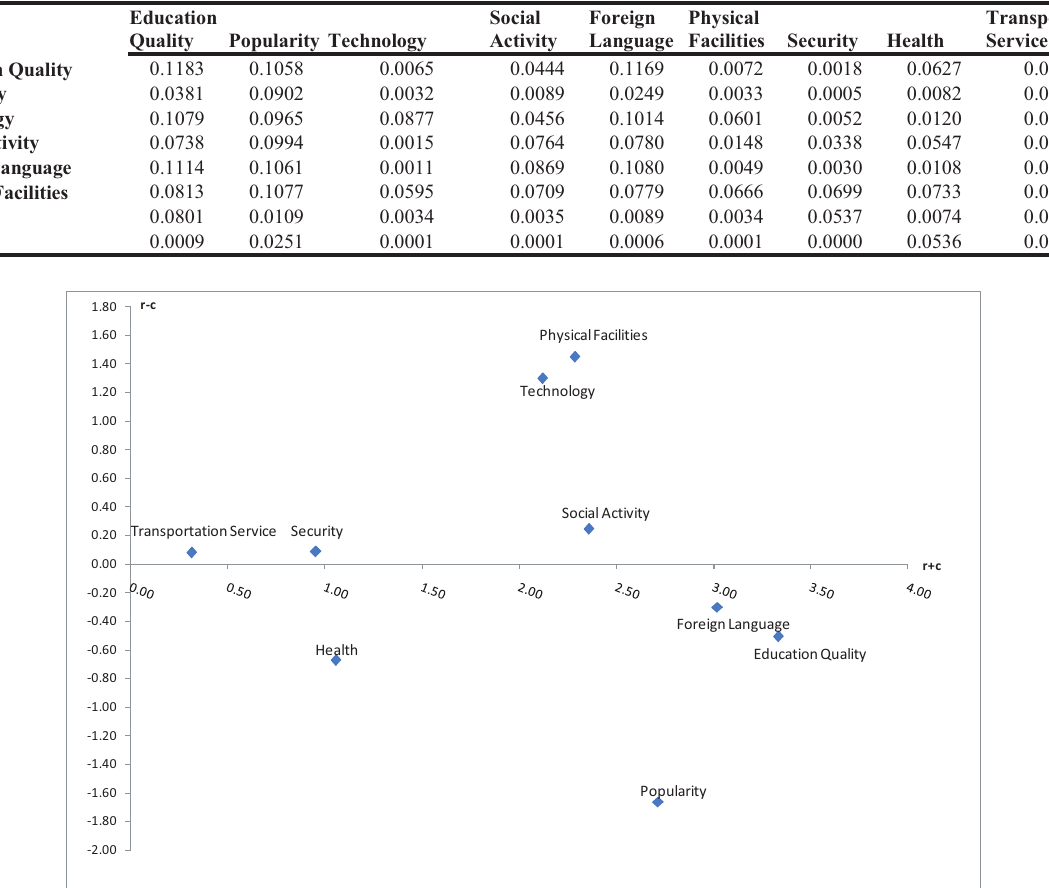
Table 5. Steady state matrix for f ( x ) = tanh(x).